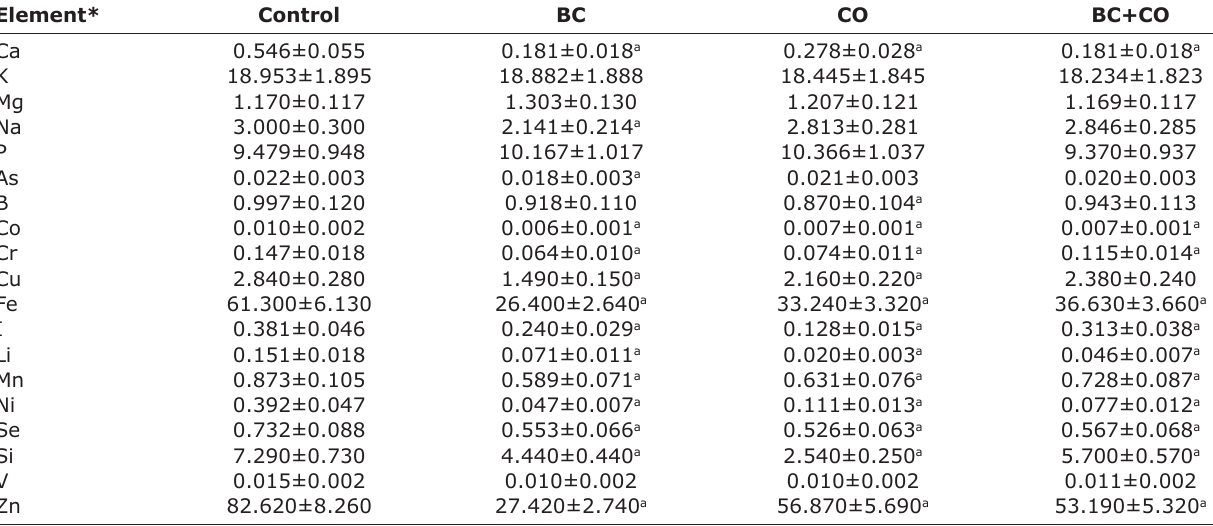
Table-8: Concentrations of chemical elements in the thigh muscles of broilers with Bacillus cereus and coumarin in diets (day 42).